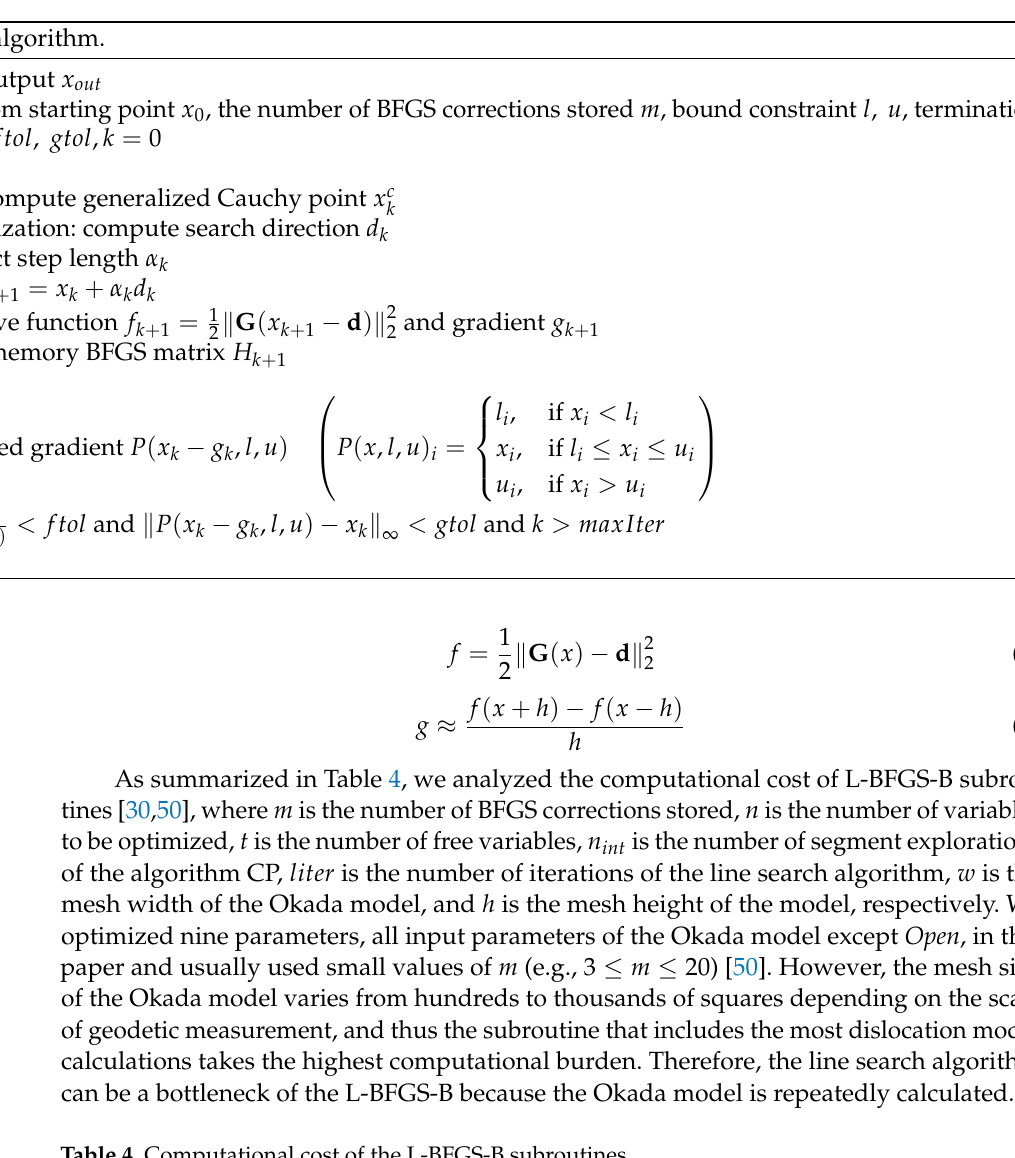
Table 4. Computational cost of the L-BFGS-B